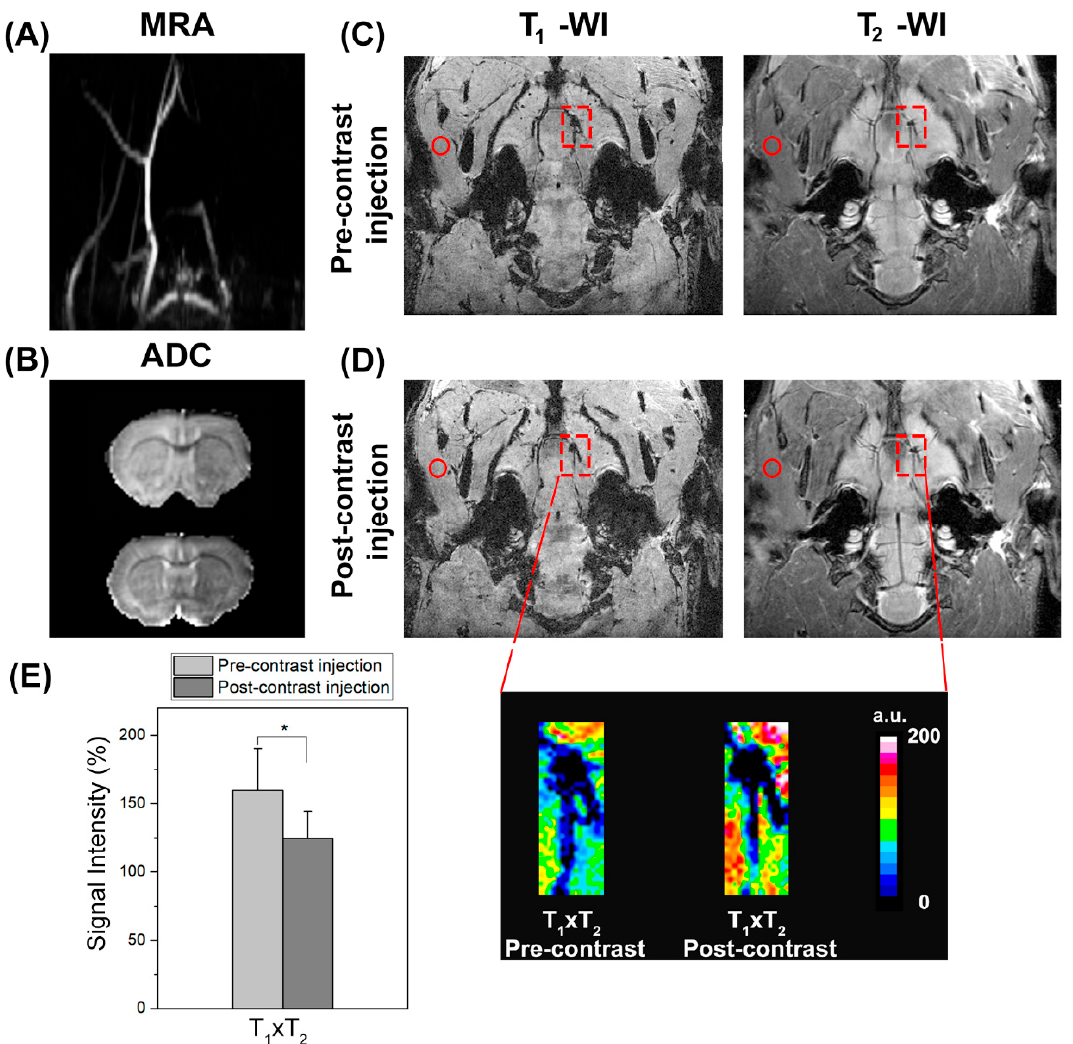
Figure 6. ( A ) Coronal intensity projection of TOF angiography showing right-sided flow deficit of rat brain due to an autologous clot (2 h incubation time). ( B ) Apparent diffusion coefficient (ADC) map at the same level showing a hypointense lesion in the MCA region. Coronal slice from T 1 - and T 2 -wis 3D at the level of the MCA origin pre- ( C ) and post-contrast ( D ) injection of KCREKA-NPs. The squares indicate the thrombus region, and the circles the adjacent muscle were used as reference for signal intensity calculations. ( E ) Corresponding T 1 × T 2 expanded reconstruction at the level of the MCA origin, revealing a significant signal intensity change in the presence of the occlusive thrombus after KCREKA-NP injection (* p < 0.05).